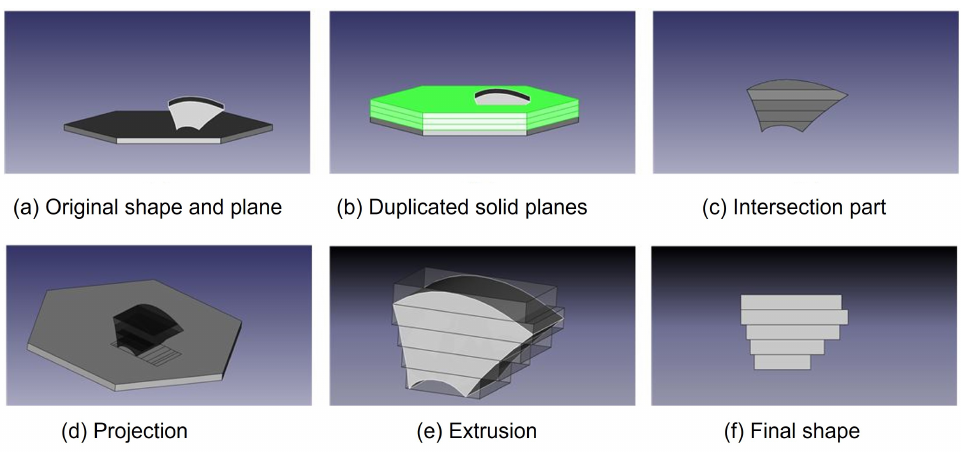
Figure 11. Squashing Operation Process: ( a ) Original Shape and solid plane, ( b ) Duplicated solid planes by vertical direction, ( c ) Intersection part, ( d ) Projection, ( e ) Extrusion, ( f ) Final Shape. Table 1. Notations of the proposed squashing operation.